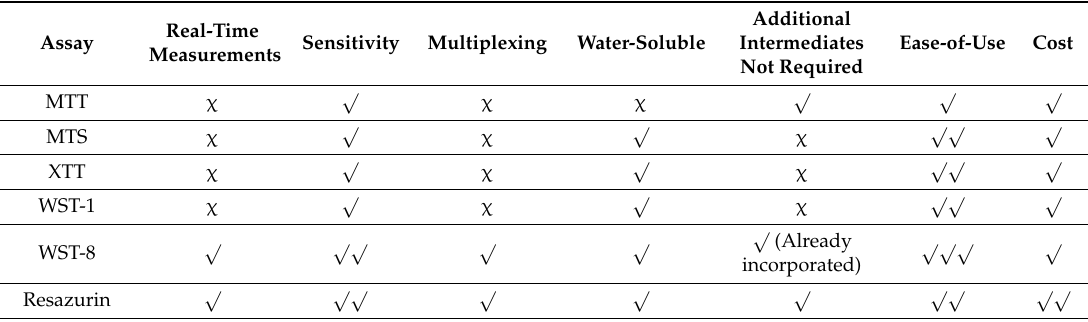
Table 1. Comparison of the advantages and disadvantages of determining cell viability and/or proliferation using various colorimetric assays. Advantages are indicated via check marks ( Disadvantages are indicated through an x ( χ ). Multiple check marks ( advantage of one assay in comparison to others